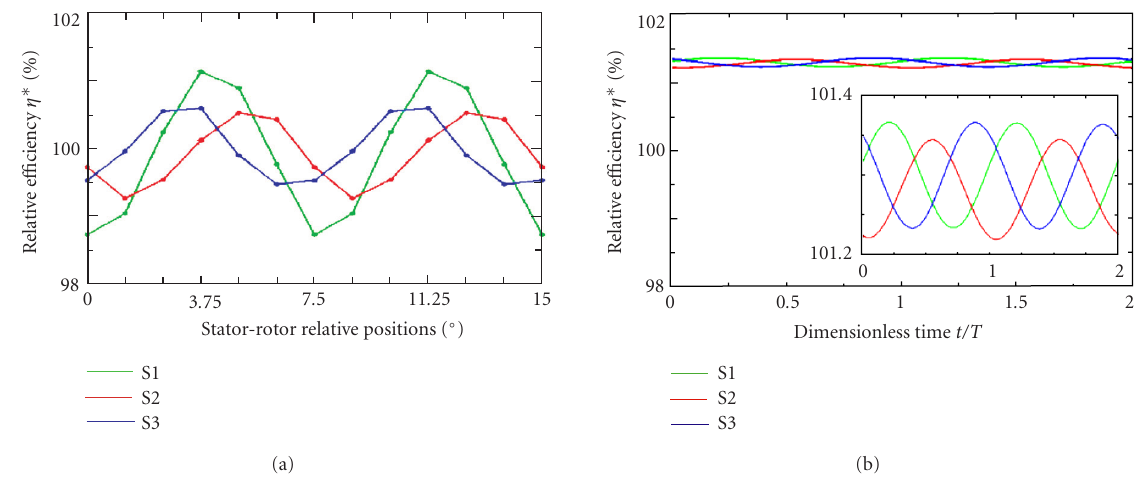
Figure 8: Relative e ffi ciency distributions. (a) Frozen rotor approach, steady calculation. (b) Sliding mesh approach, unsteady calculation.